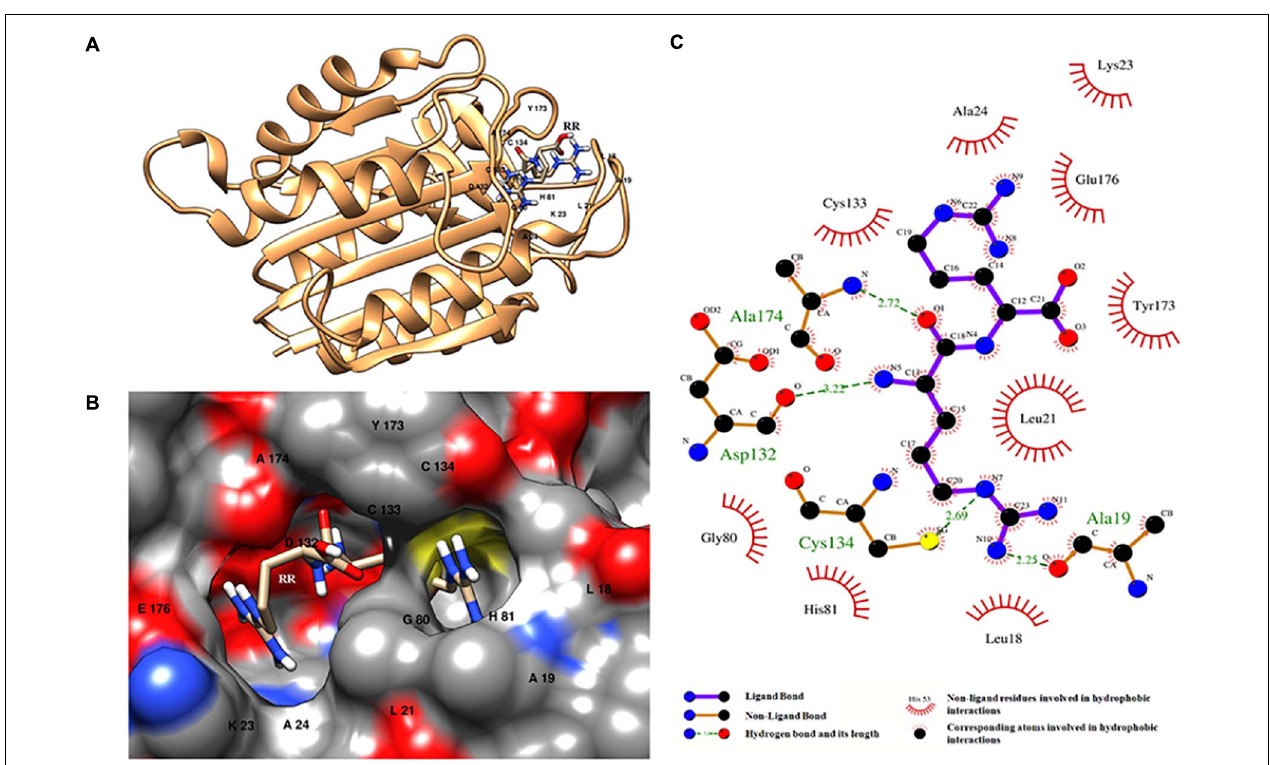
FIGURE 6 | HC–RR complex formed upon docking RR dipeptide with wild-type orthocaspase, WP_010999143.1 (HC), of Nostoc sp. PCC 7120. (A) Binding position of substrate on the protein. (B) Binding pocket accommodating the substrate along with the interacting residues shown with a single-letter amino acid code and position specifier. (C) Interacting amino acid residues and the type of interaction with the substrate; amino acids are shown in a three-letter code with the position specifier.